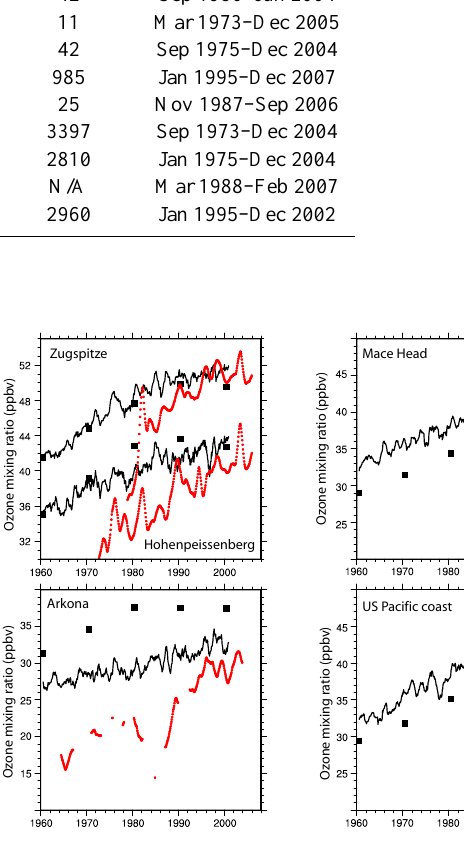
Fig. 5. Time evolution (1960–2009) of surface ozone (12-month running mean) at a variety of sites. Observations are in red, CAM- chem results are in black (solid line) and G-PUCCINI results are in black (solid